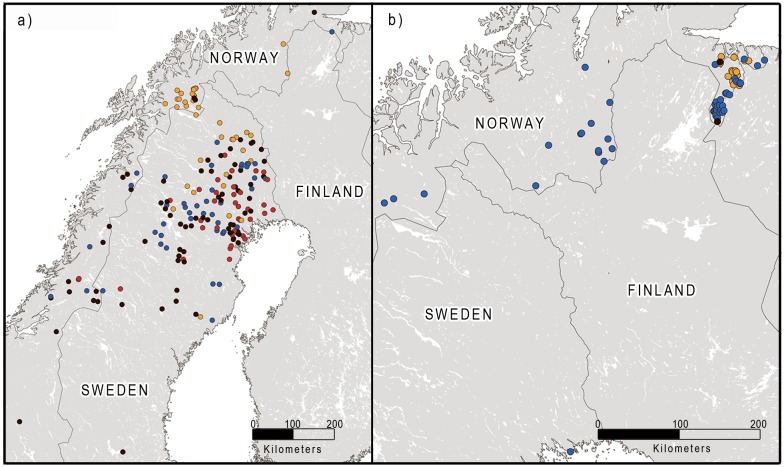
Location of male brown bears belonging to the different genetic subclusters in Scandinavia, determined by the reanalysis of each previously determined cluster.Individuals whose membership could not be determined (q < 0.7) are colored black. a) subclusters within cluster 3, b) subclusters within cluster 4. Note that the colors used to depict subcluster membership do not correspond to the color coding used in the other maps.